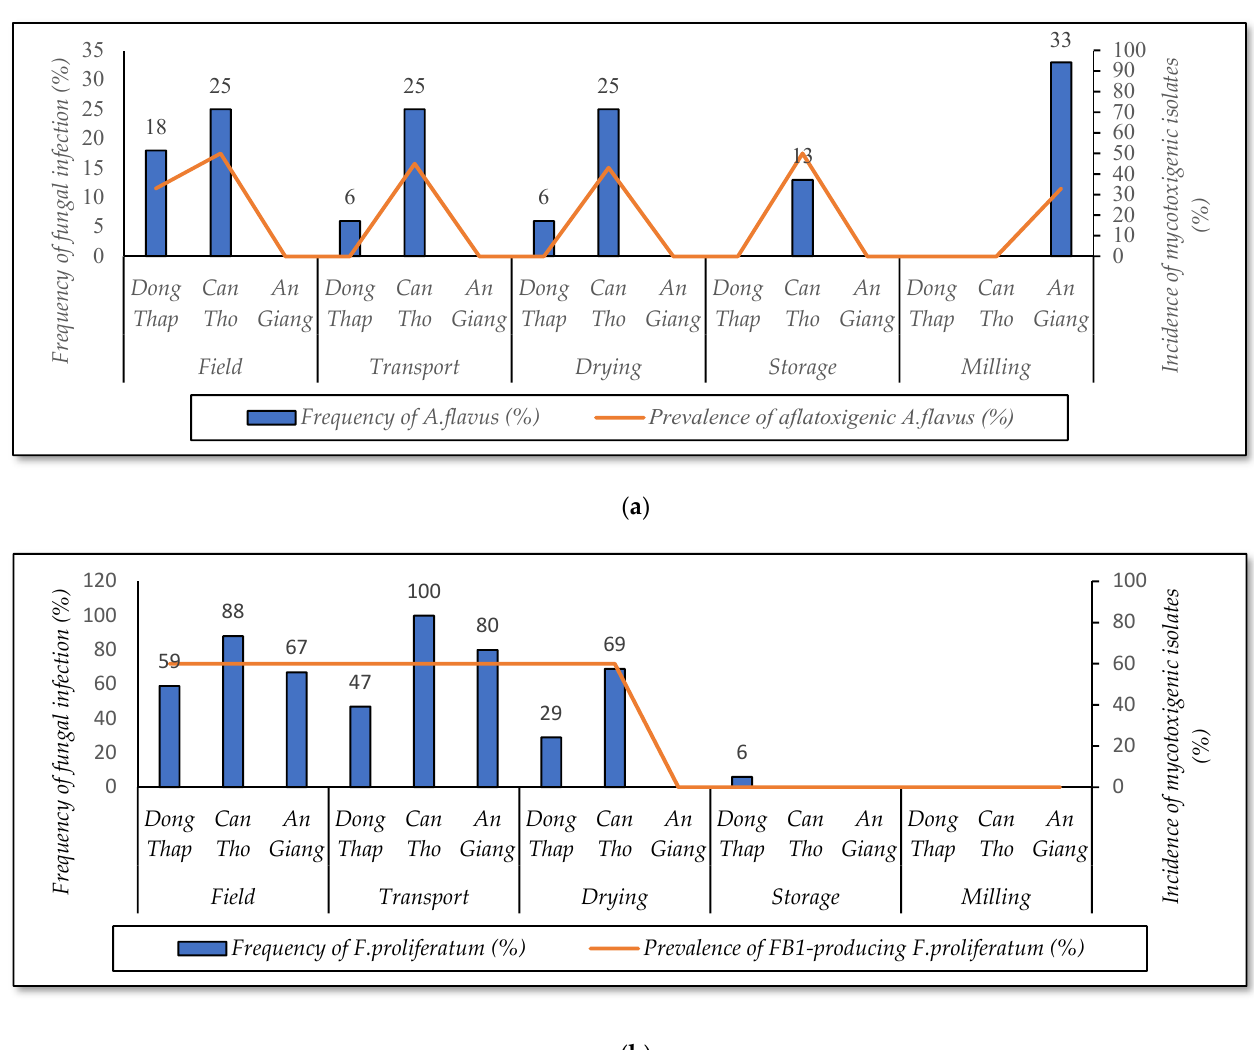
Figure 5. Percentage of A. flavus ( a ) and F. proliferatum ( b ) contaminated samples and mycotoxigenic isolates in different locations in Mekong Delta.